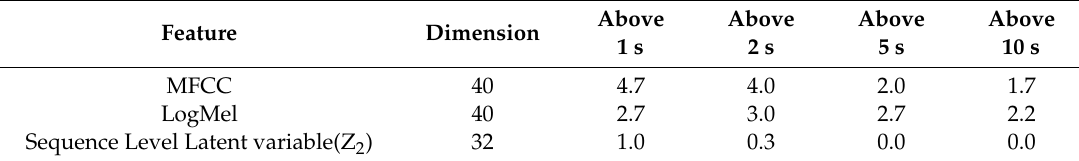
Table 2. Classification error rate for di ff erent utterance times in seconds.